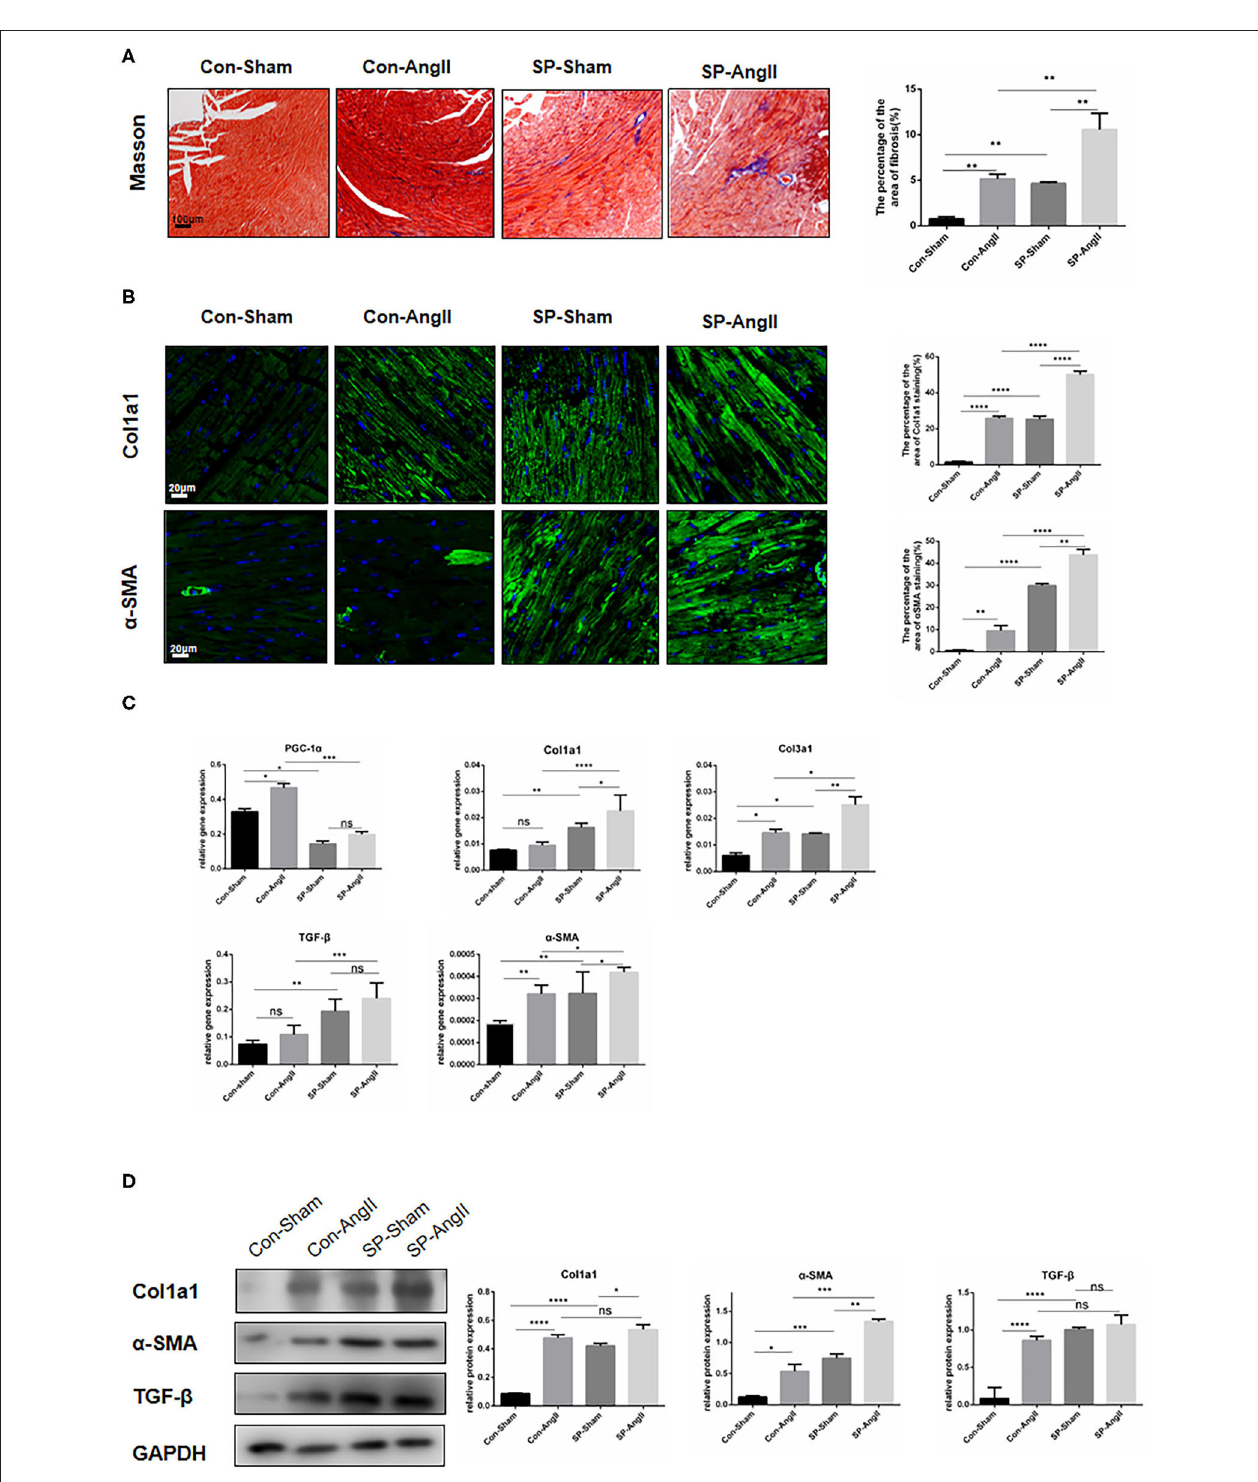
FIGURE 1 | Cardiac fibroblast-specific PGC-1 α KO aggravates cardiac remodeling. (A) Representative cross sections of the heart stained for Masson and quantitative analysis of the area of fibrosis (Masson staining). (B) Representative immunofluorescent staining of Col1a1 and α -SMA and quantitative analysis of immunofluorescent staining of Col1a1 and α -SMA. (C) qPCR analysis of mRNA expression levels of PGC-1 α and fibrotic genes ( Col1a1 , Col3a1 , α -SMA , TGF- β ). (D) Representative Western blot and analysis of the expression of fibrotic proteins (Col1a1, α -SMA, TGF- β ). N.S. indicates no significant difference. * p < 0.05, ** p < 0.01, *** p < 0.001, **** p < 0.0001. Data represent mean ± SEM ( n = 5 per group).